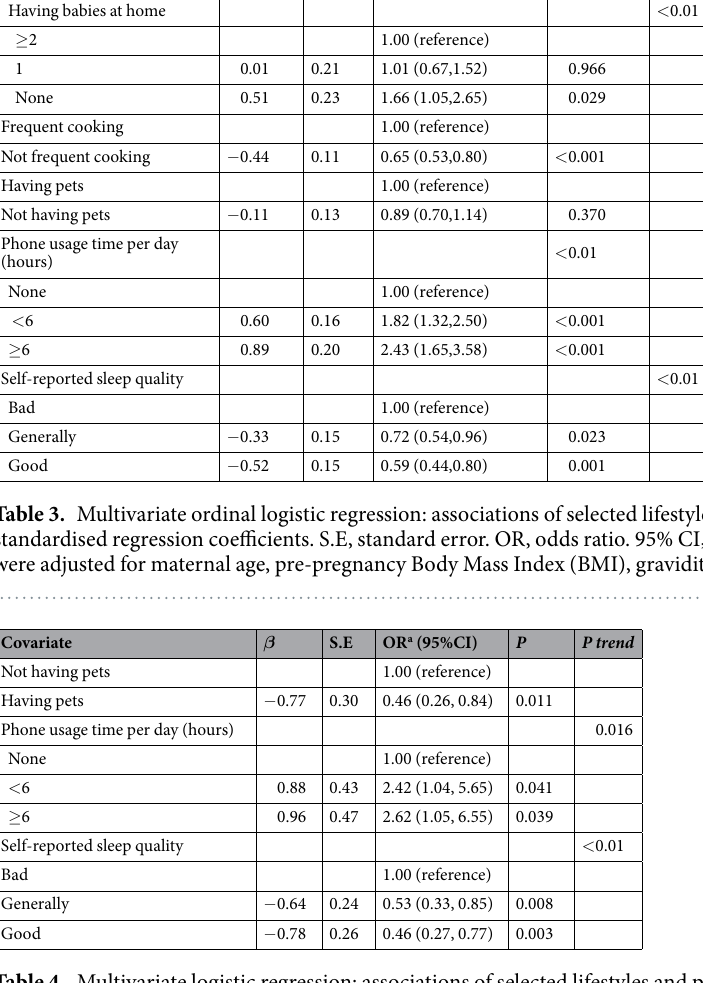
Table 4. Multivariate logistic regression: associations of selected lifestyles and prenatal anxiety. β , standardised regression coefficients. S.E, standard error. OR, odds ratio. 95% CI, 95% confidence interval. a ORs were adjusted for maternal age, gravidity